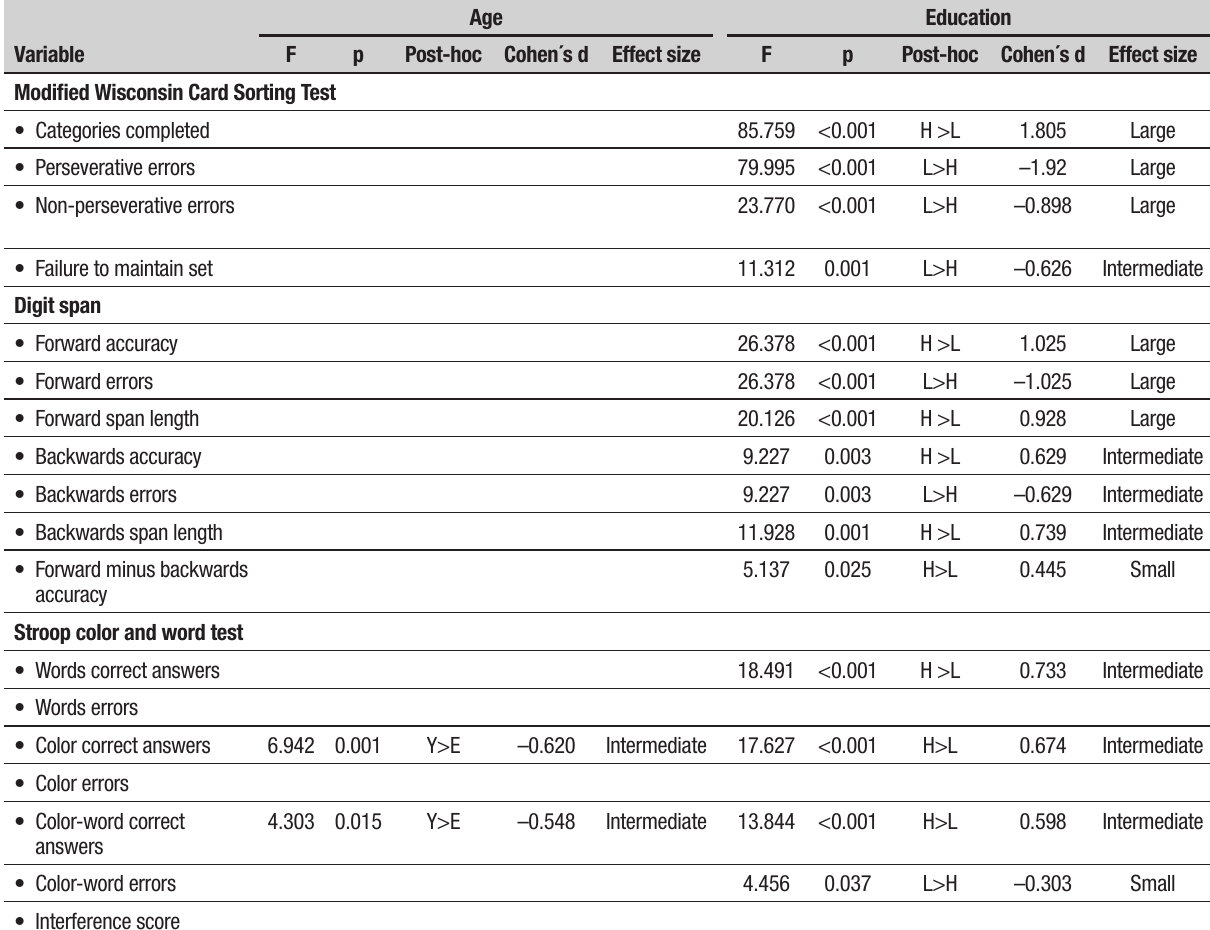
Table 5. Age and education effects on performance of MWCST, Digit span, and Stroop color and word test.